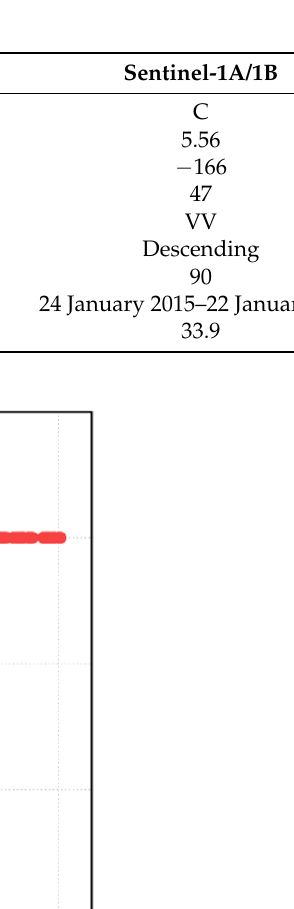
Table 1. Information of the SAR dataset.